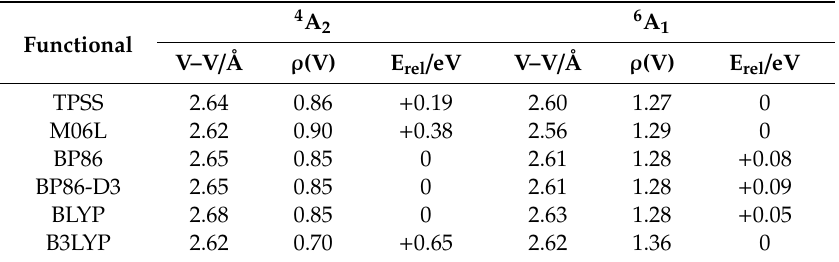
Table 1. Relative energies, V–V bond lengths and Mulliken spin densities for the 4 A 2 and 6 A 1 states of [V 4 N 4 ] + . The energetic reference point is taken as the more stable of the two states. 6 A 4 A 2 Functional